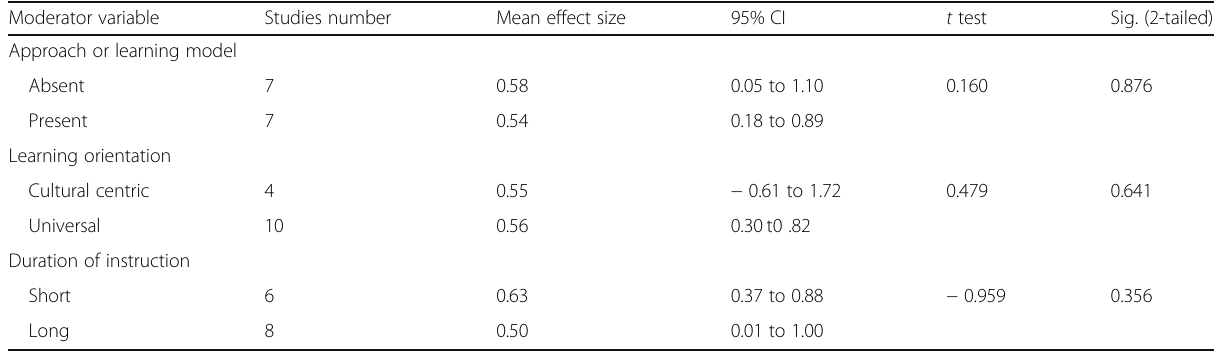
Table 4 Moderator variable analysis of